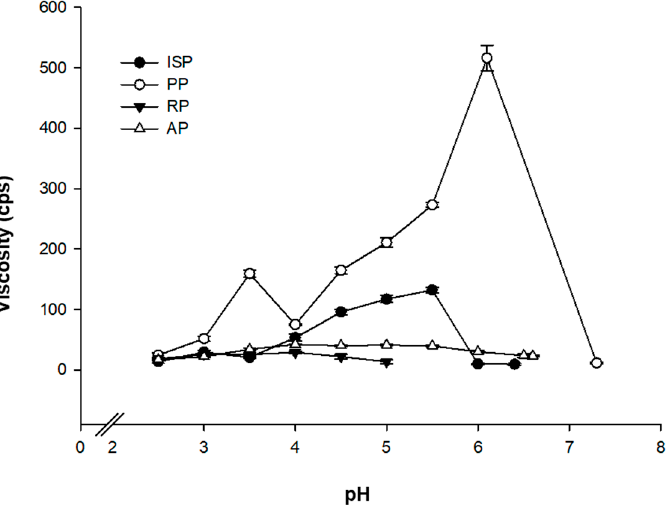
Figure 3. Apparent viscosities of plant protein solutions (5%, w / w ) at different pH levels after the physical treatment (pasteurization and homogenization). ISP: isolated soy protein; PP: pea protein; RP: rice protein; AP: almond protein.